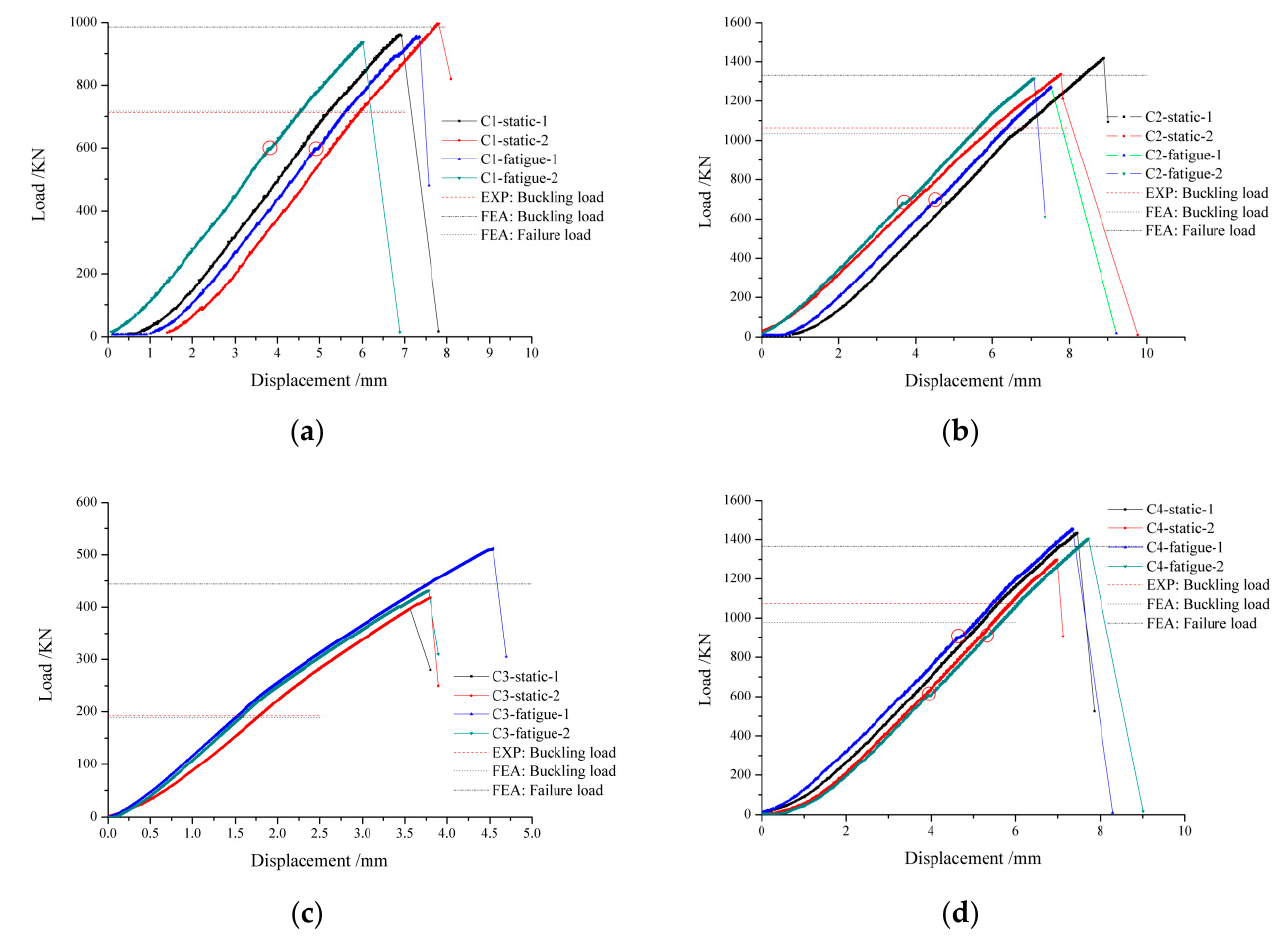
Figure 10. The load-displacement curves for all the specimens. ( a ) C1; ( b ) C2; ( c ) C3; ( d ) C4.